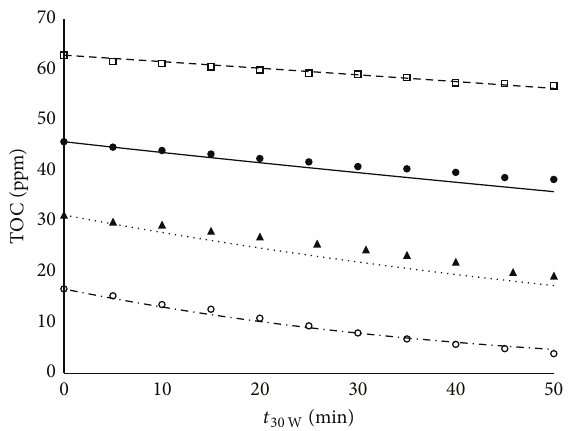
Figure 8: Solar mineralization of binary mixtures at 120